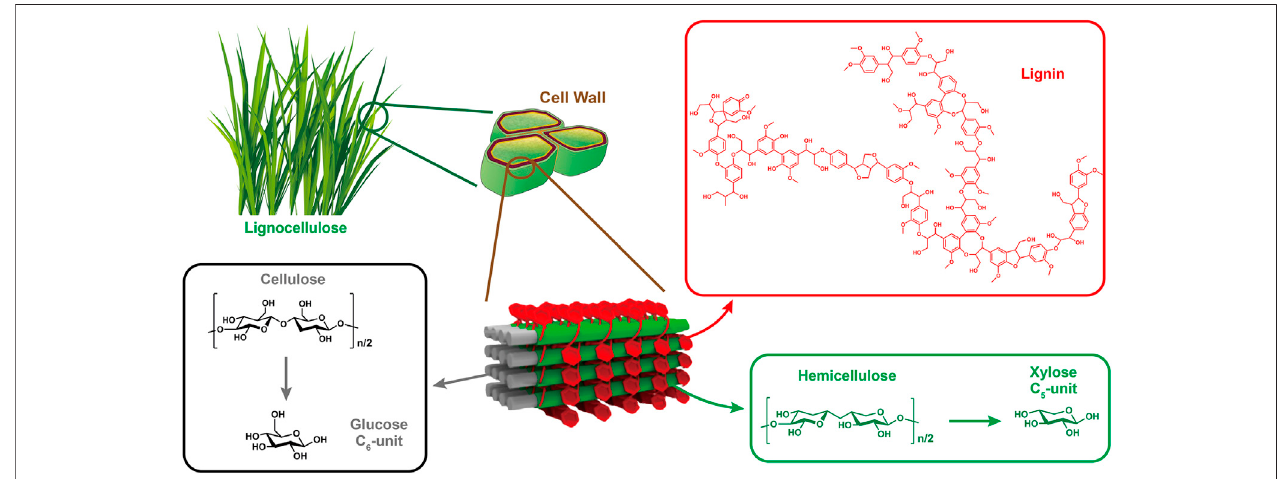
FIGURE 1 | Schematic of the structure of